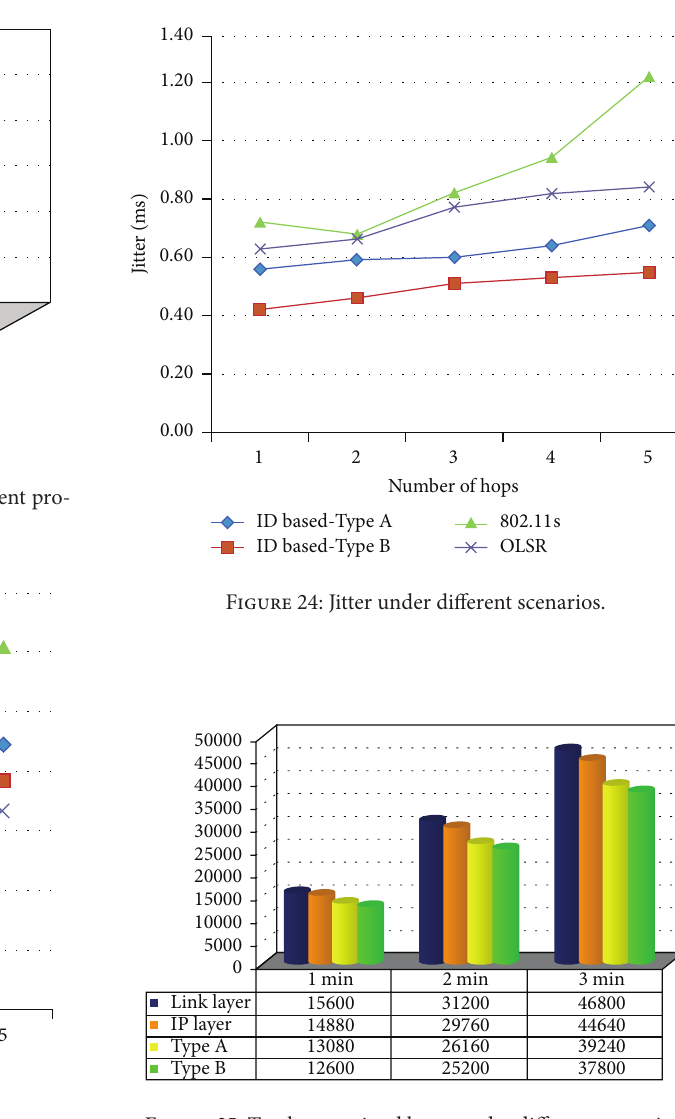
Figure 21: P2P ID based application sending and receiving data.